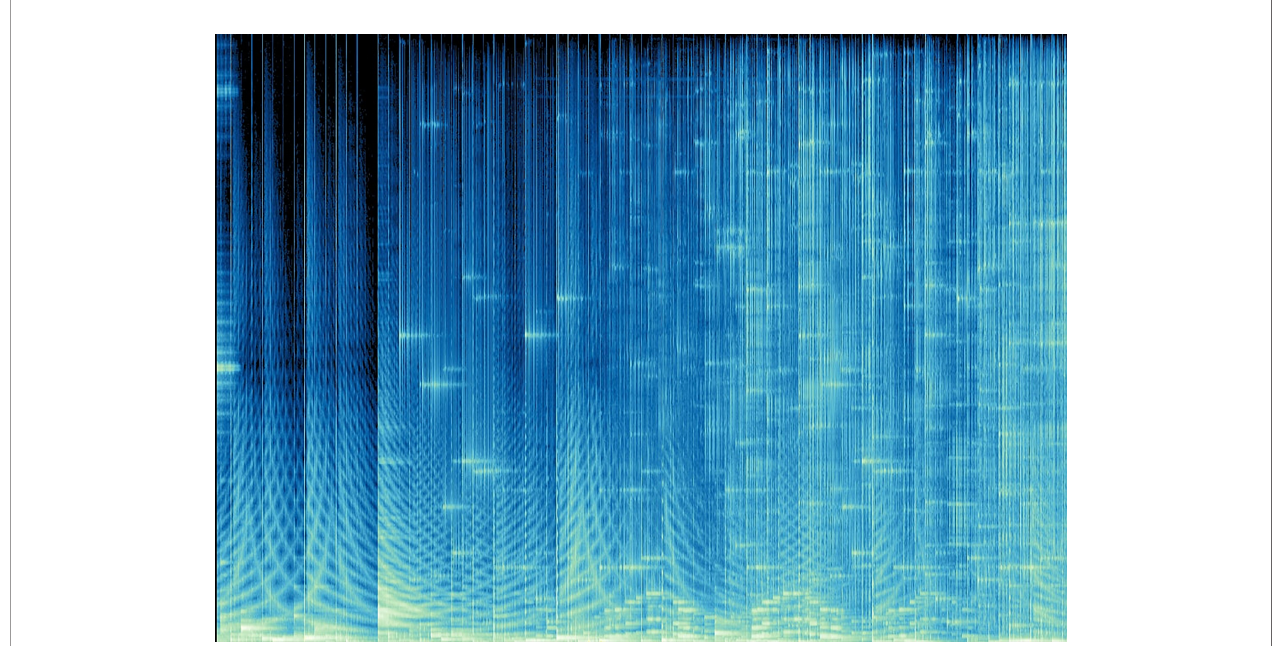
FIGURE 7 | Samuel Hertz, 2021: Mirror 2, from the series Four Aquatic Mirroring Devices by Samuel Hertz for Radio Amnion. The accompanying musical compositions were transmitted to the deep ocean via the Radio Amnion installation in September 2021. Hertz “ imagines this relation to water, across bodies, sound and light … . [The] four mirrors offer re fl ective and refractive ways to understand more-than-physical relationships within and among water, within and among parts that are whole, or wholes, which appear to slide apart ”